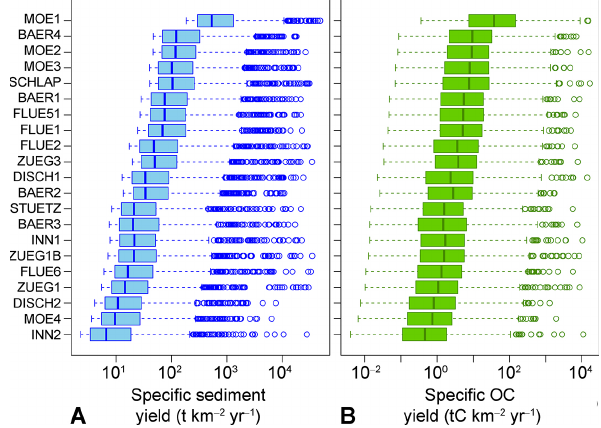
Fig. 5. Box-and-whisker plots for simulated specific sediment and organic carbon yields from n = 21 snow-avalanche cones in the area around Davos, eastern Swiss Alps. Boxes enclose interquar- tile range (thick vertical lines are median values); whiskers cover 1.5 times the interquartile range; circles are outliers. Simulated data from the method outlined in the text assuming a power-law dis- tributed deposit area with minimum A min = 100m 2 . Plot highlights the spatial ( = between-site) variability of specific sediment and car- bon yields, which for a given median, spans two orders of magni- tude.